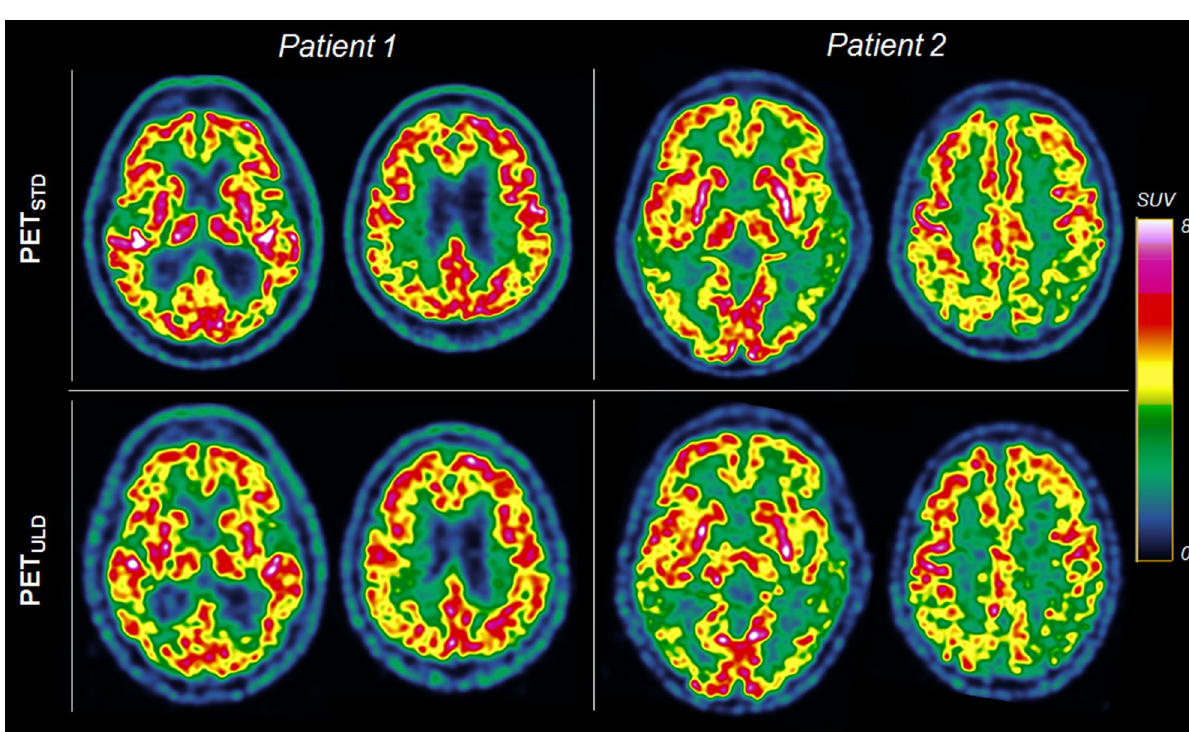
Figure 1. Transverse slices of two patients suspected of AD with mild hypometabolism (patient 1) and severe hypometabolism (patient 2) with standard dose (PET STD , 2 MBq/kg) and ultra-low dose (PET ULD, 0.2 MBq/kg) protocol. The transverse slices are extracted from the Advantage Workstation (AW server 3.2, GE Healthcare) used to carry out the